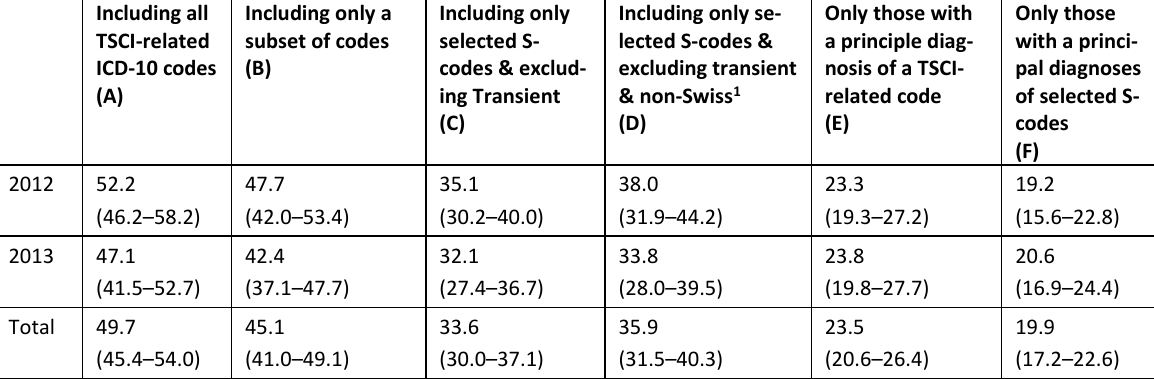
Table S2: Incidence rates per million population stratified by year of